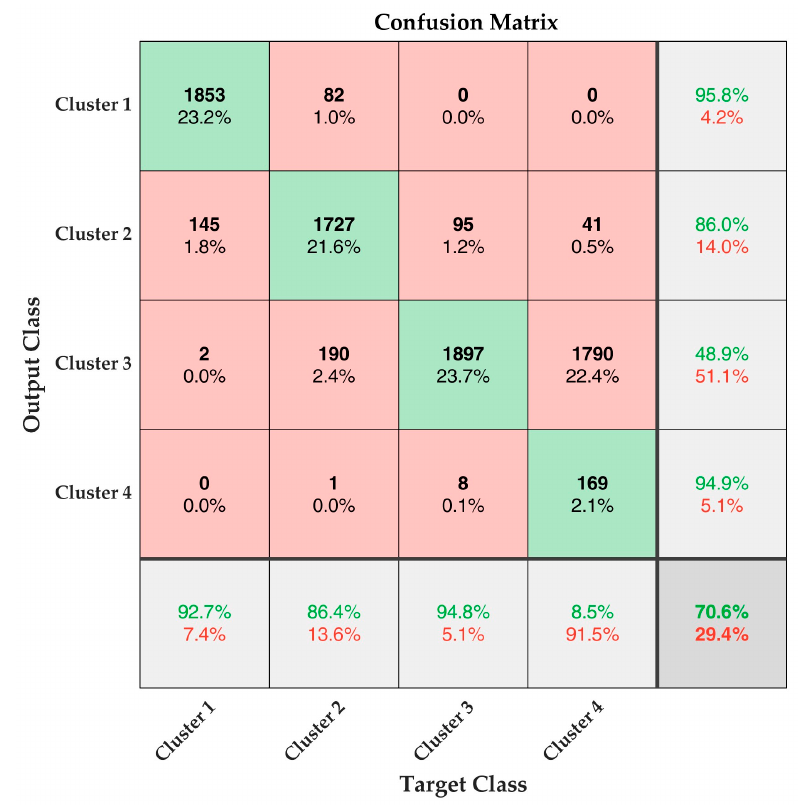
Figure 6. Classification Efficiency of the SqueezeNet ‐ based CNN represented as Confusion Matrix.